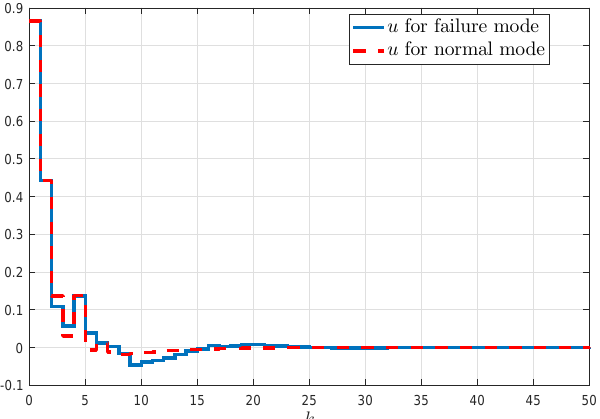
Figure 5. The response of system control input u